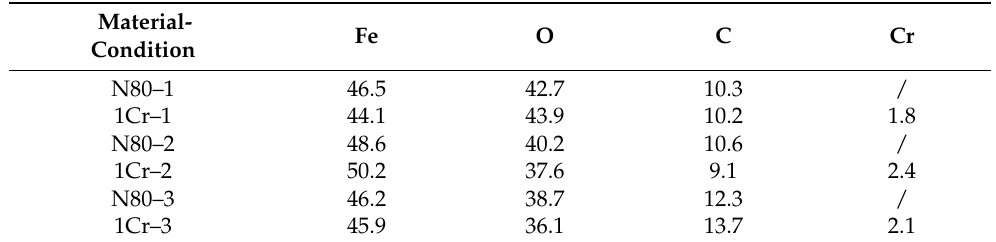
Table 5. EDS analysis of product film of the specimens under different corrosion conditions (normal- ized mass percentage: less than 0.5% not